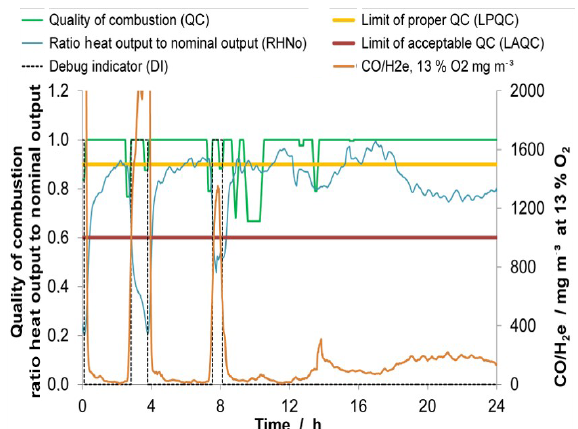
Figure 6. Example of the calculated quality of combustion (QC) in a wood-chip combustion unit with 88kW of nominal heat output in field operation over a whole day in the winter